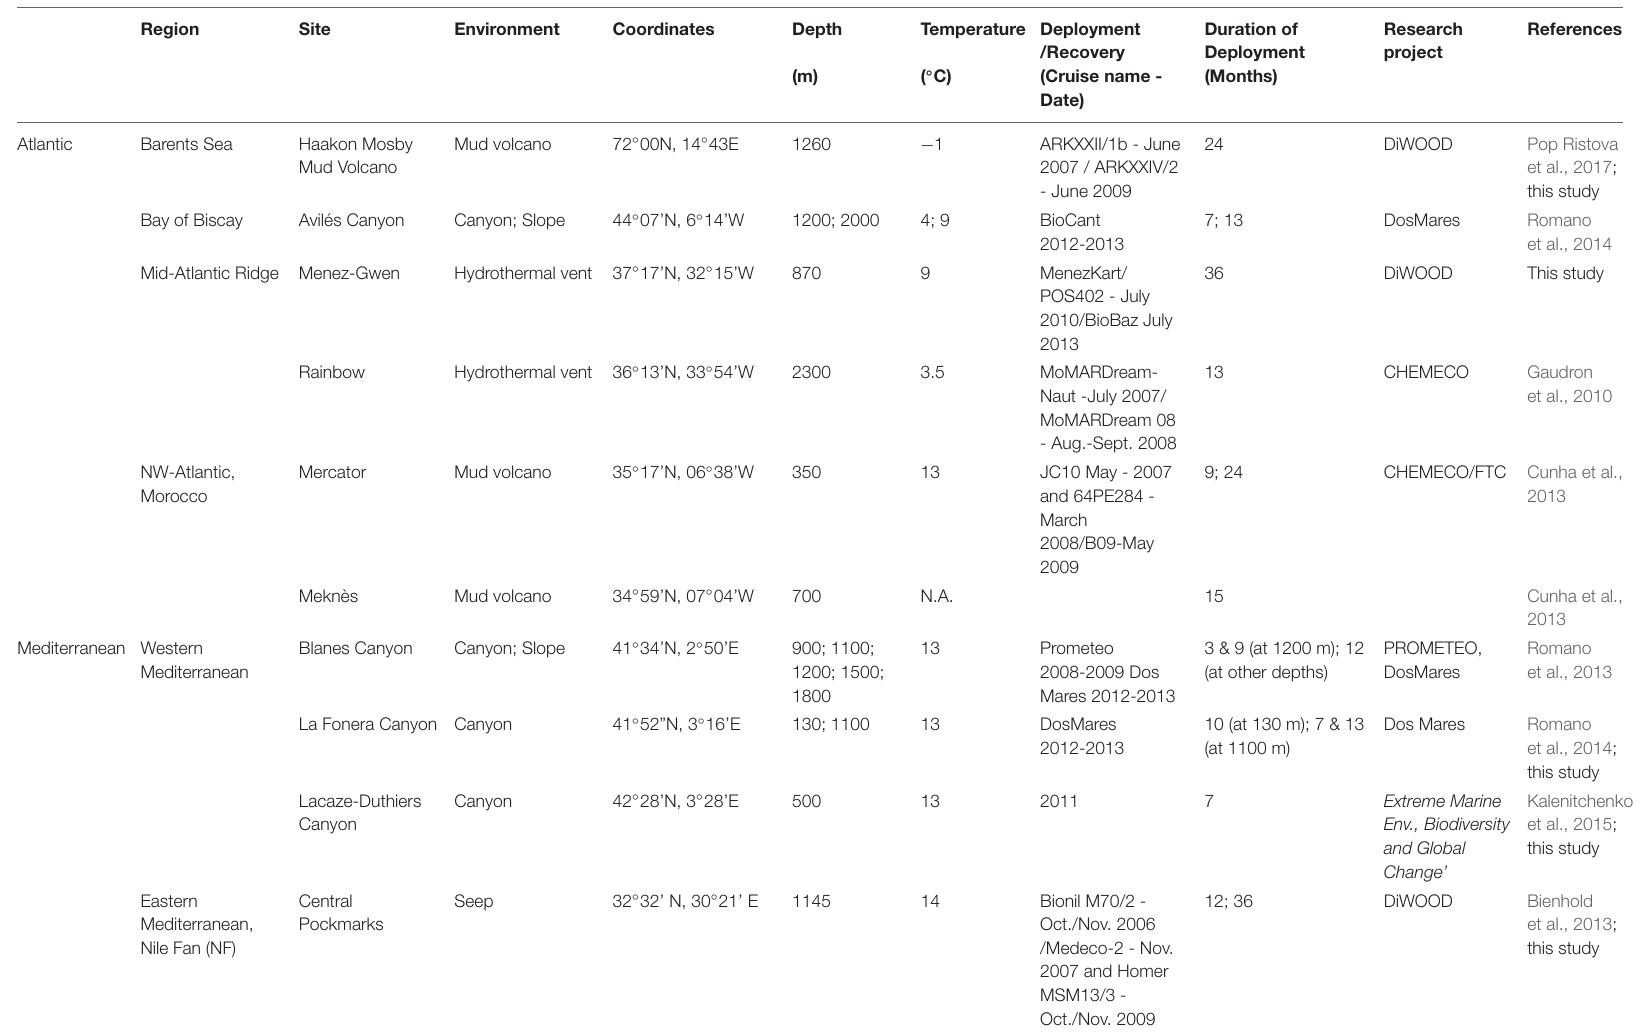
TABLE 1 | Characteristics of deployment sites and colonization